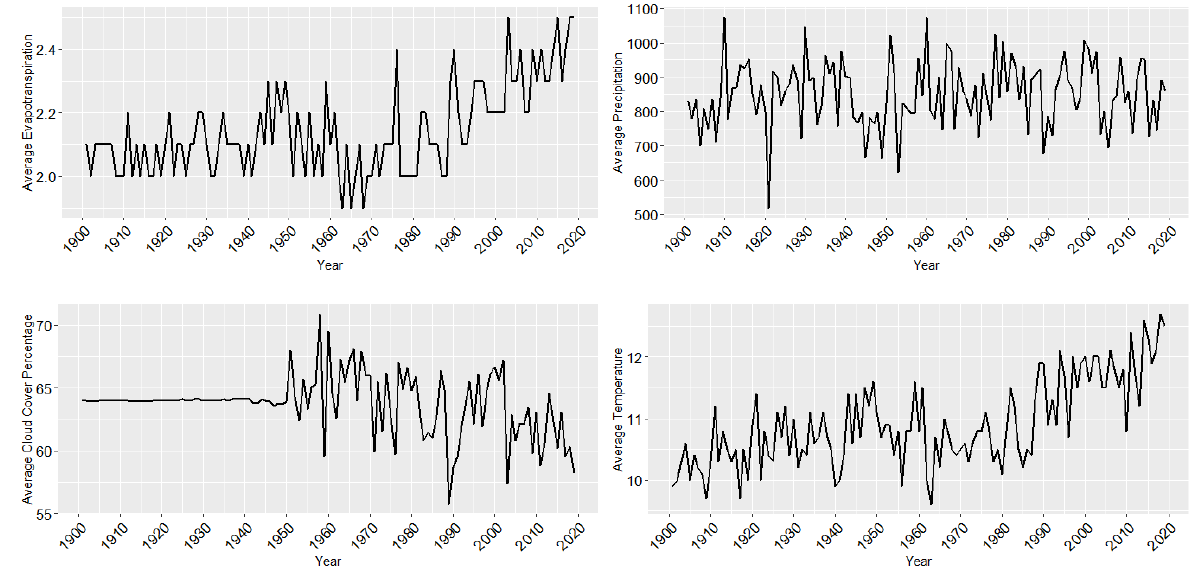
Figure 7. Annual average of climatic historical trends for France.